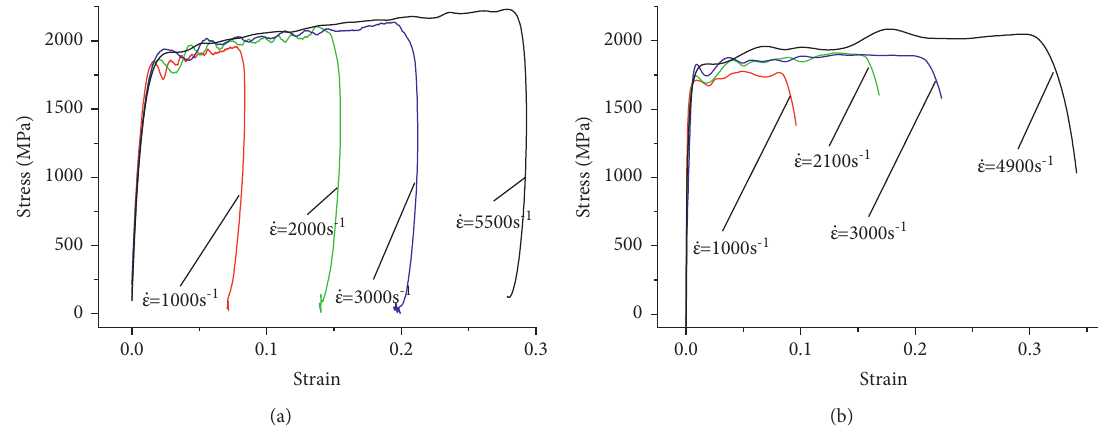
Figure 12: Dynamic compression stress-strain curve at room temperature. (a) QP980 steel RSW; (b) TRIP800 steel RSW. Table 5: Experimental conditions of the dynamic compression of QP980 steel spot welds under heating condition. Temperature ( ° C) Height of specimen (mm) Diameter of specimen (mm)